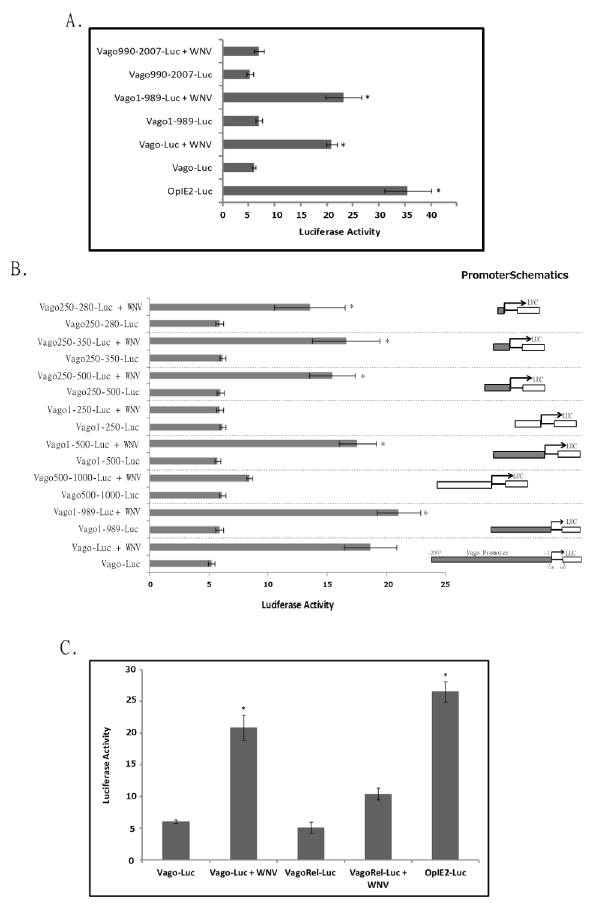
Figure 2. The Rel-binding site is responsible for WNV-induced Cx Vago activation. ( A ) Hsu cells were transfected with Renilla luciferase plasmid containing Vago promoter region ( , 2 kb region upstream of gene, Vago-Luc) or , 1 kb promoter fragments (Vago1- 989-Luc and Vago990-2007-Luc). Cells were also transfected with firefly luciferase plasmid under the insect promoter ( OpIE2 ) as an internal control. As a positive control, cells were transfected with Renilla luciferase under OpIE2 promoter (OpIE2-Luc). After 24 h, the cells were infected with WNV and luciferase activity was measured at 24 hpi. ( B ) Hsu cells were transfected with Renilla luciferase plasmid containing Vago promoter (Vago-Luc) or smaller fragments of the promoter along with plasmid containing the firefly luciferase reporter (OpIE2 promoter, internal control). After 24 h, the cells were infected with WNV and luciferase activity was measured at 24 hpi. The schematics of the promoter region used in the assay is provided in the right panel. The solid promoter regions were involved in inducing luciferase expression after WNV infection. ( C ) Hsu cells were transfected with Renilla luciferase plasmid containing Vago promoter (Vago-Luc) or promoter with a mutated Rel-binding site (VagoRel-Luc) along with firefly luciferase plasmid (OpIE2 promoter, internal control). As a positive control, cells were transfected with Renilla luciferase under OpIE2 promoter (OpIE2-Luc). After 24 h, the cells were infected with WNV and luciferase activity was measured at 24 hpi. The Renilla luciferase activity values were standardised using firefly luciferase activity values (R/F) and resulting values were plotted as bar graphs. Error bars represents standard error from three separate experiments with assays performed in triplicate and values were compared to ‘Vago-Luc’ (Student’s t-test *p ,